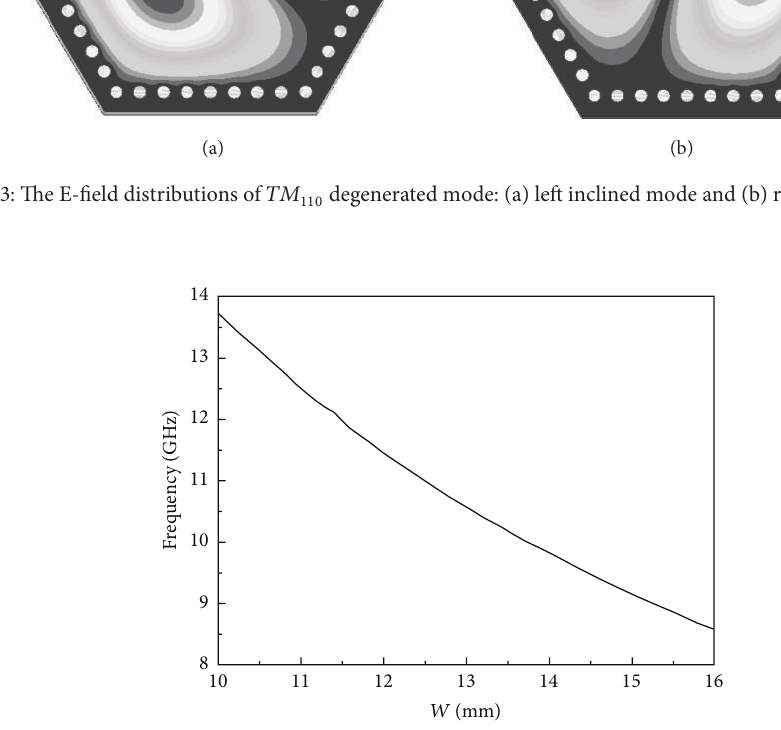
Figure 4: Resonant frequencies with different values of 𝑊